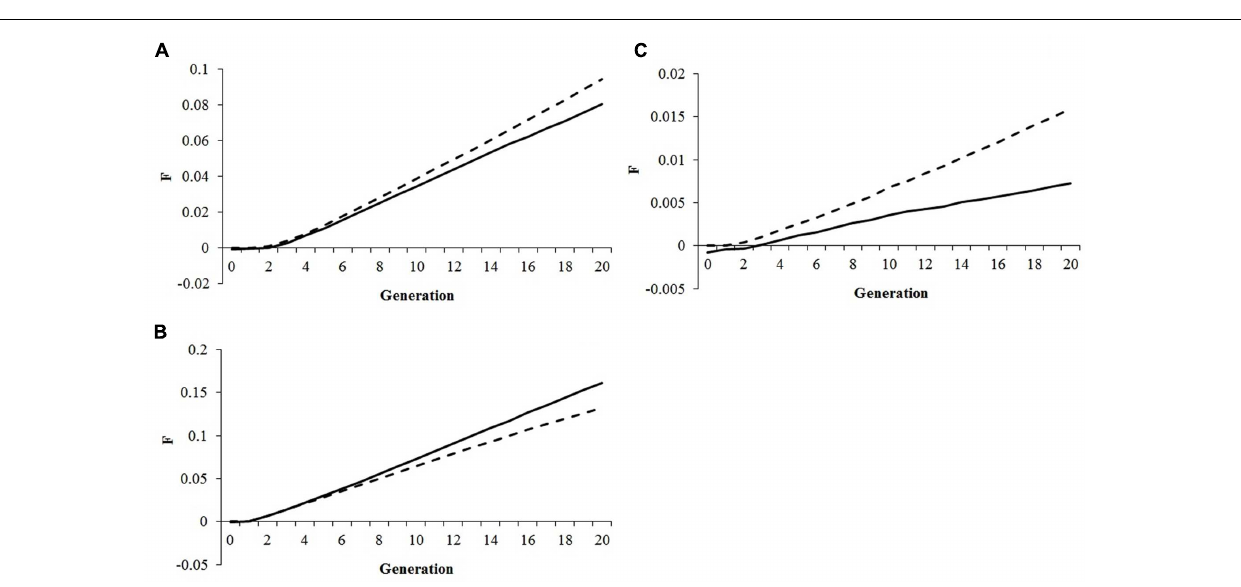
FIGURE 2 | Comparison between the rates of genomic ( (cid:49) F G , solid lines) and pedigree ( (cid:49) F P , dashed lines) inbreeding during the selection period. (A) MGa with 50% selection emphasis on fitness assuming a constraint of 0.005 in the rate of genomic inbreeding and all animals having fitness records; (B) MI with 50% selection emphasis on fitness assuming a constraint of 0.30 in the rate of gain for the index and all animals having fitness records; (C) Truncation selection for the best 10% of animals with 50% selection emphasis on